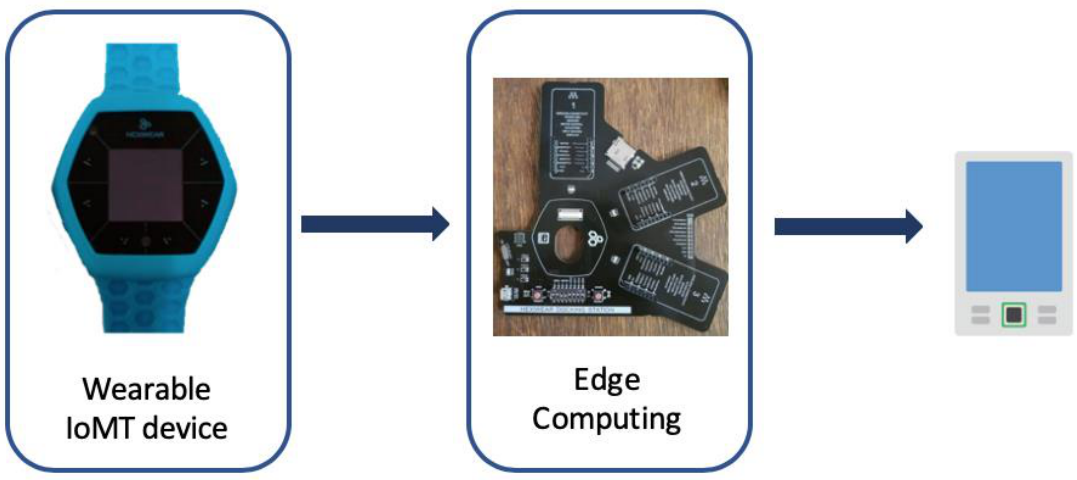
Figure 1. Internet of Medical Things (IoMT) system architecture.